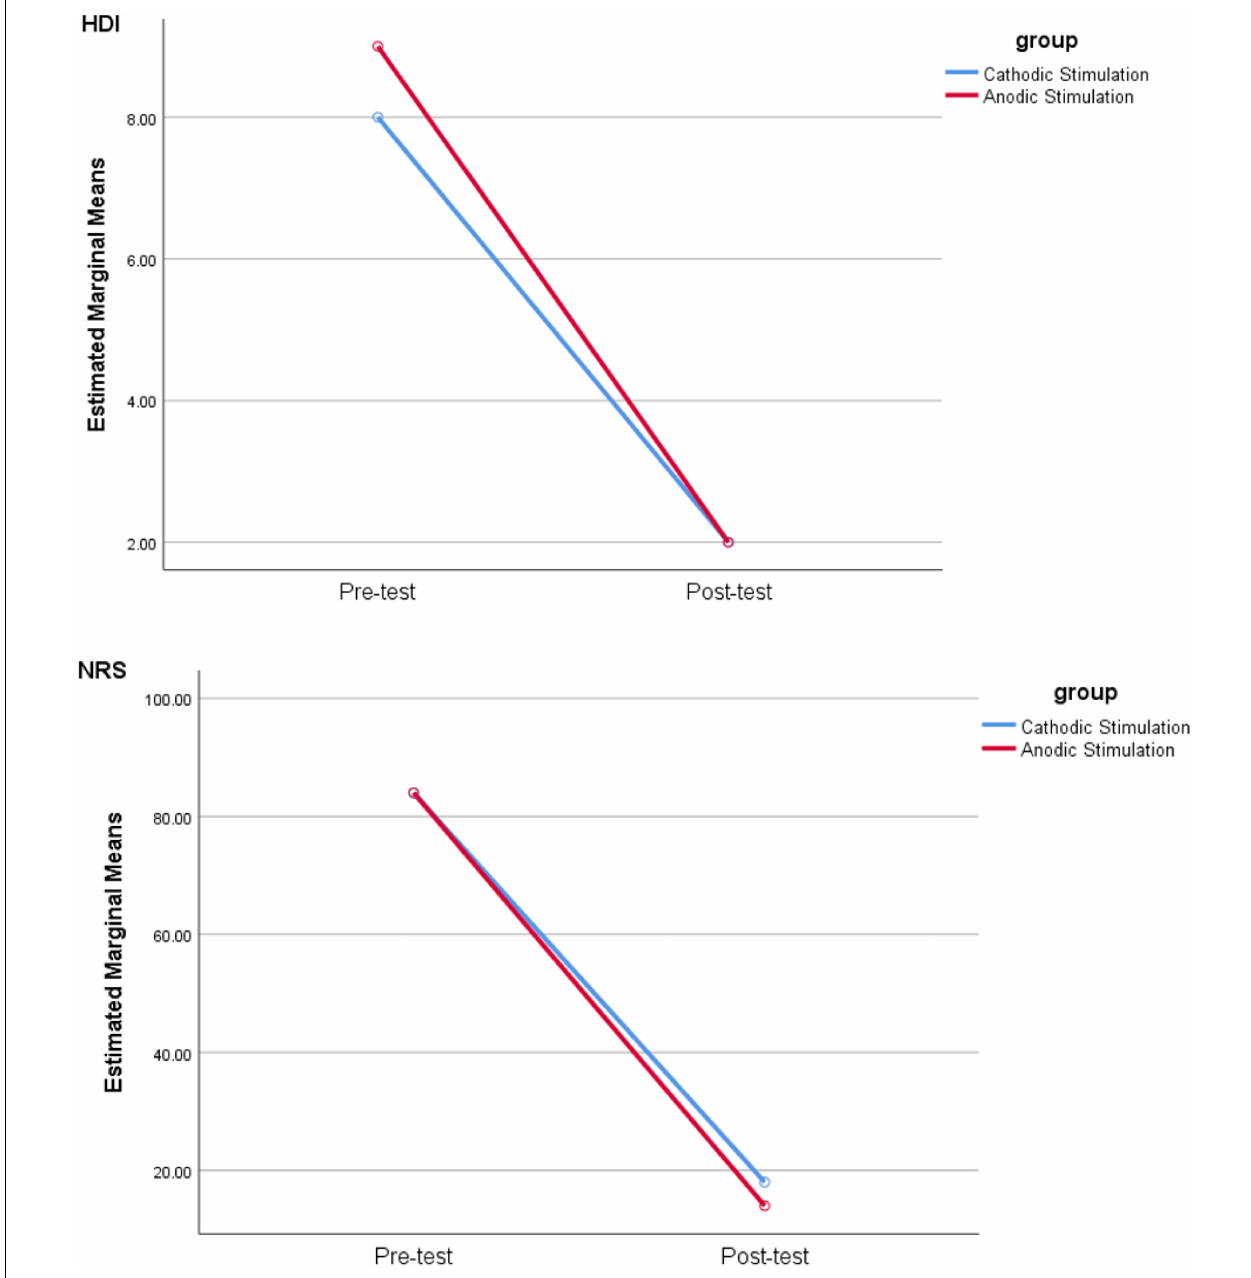
and contralateral caudate and the ipsilateral SSC.